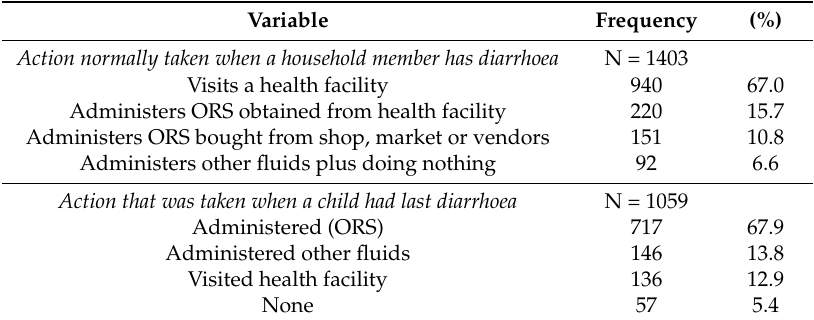
Table 1. Summary measures for outcome variables on diarrhoeal care seeking